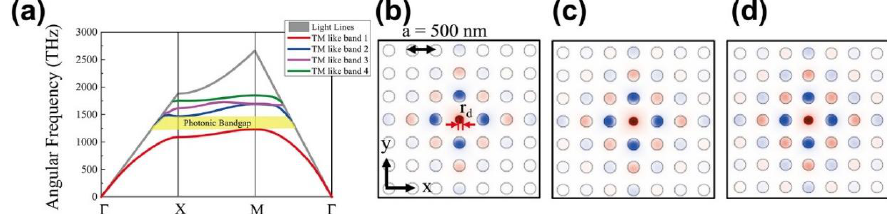
Figure 4. ( a ) Photonic band diagram of the proposed structure for a cylinder height ( H ) of 1000 nm, thin SiO 2 layer thickness ( t ) of 10 nm, and cylinder radius ( r ) of 125 nm; ( b – d ) z-component electric field mode profiles of cavity modes with different defect radius ( r d ); ( b ) r d = 80 nm; resonant wavelength 1549 nm; total quality factor = 670; ( c ) r d = 85 nm; wavelength = 1568 nm; total quality factor = 1000; ( d ) r d = 90 nm; wavelength 1612 nm; total quality factor = 4900. The mode profiles are obtained at the vertical center of the cylinder.